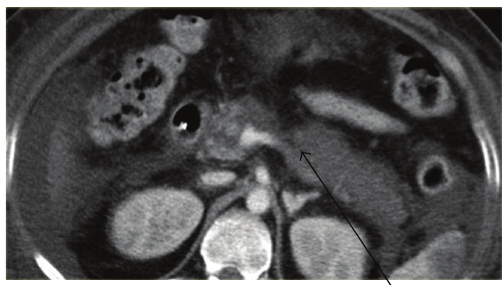
Figure 1: Representative CT scan of severe acute pancreatitis. CT scan with oral and intravenous contrast: > 50% of the pancreas does not enhance consistent with necrotizing